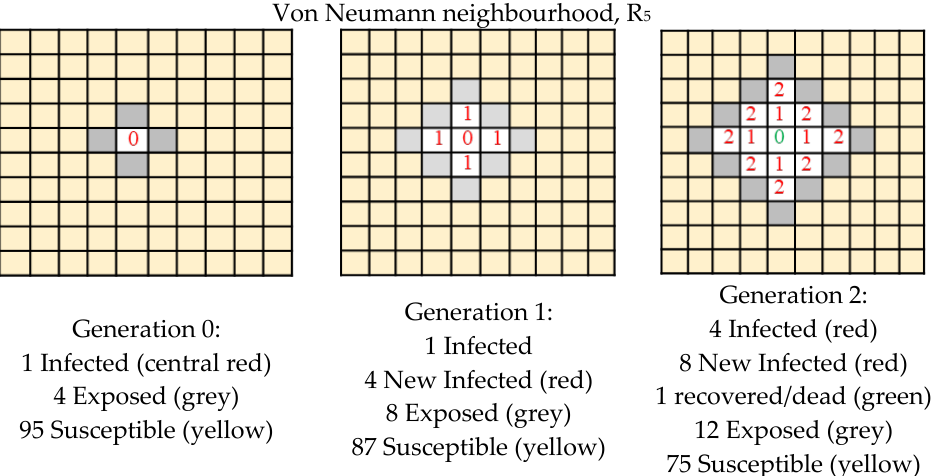
Figure 4. Expansion schedule shown for the three first generations (Von Neumann neighbourhood).